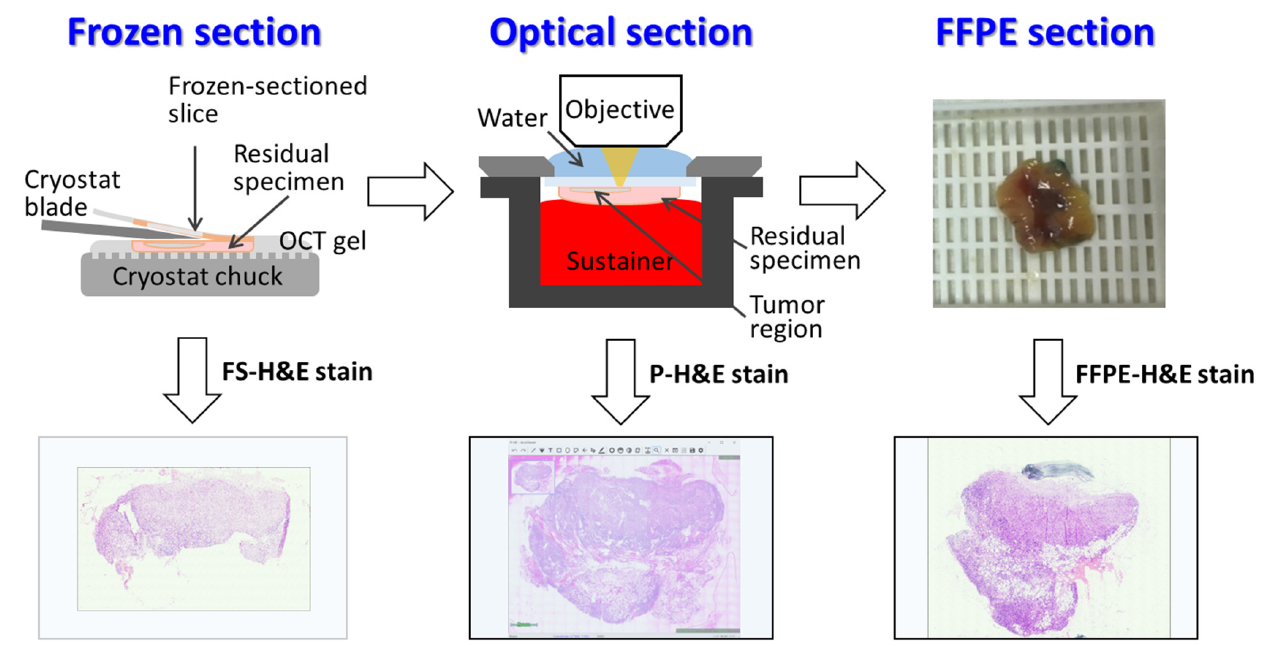
Figure 3. Three pathways—frozen section (FS), optical section, and formalin-fixed paraffin-embedded (FFPE) section—were used for the same raw specimen in a tissue processing series. With FS-H&E, p-H&E, and FFPE-H&E stains, three individual images were